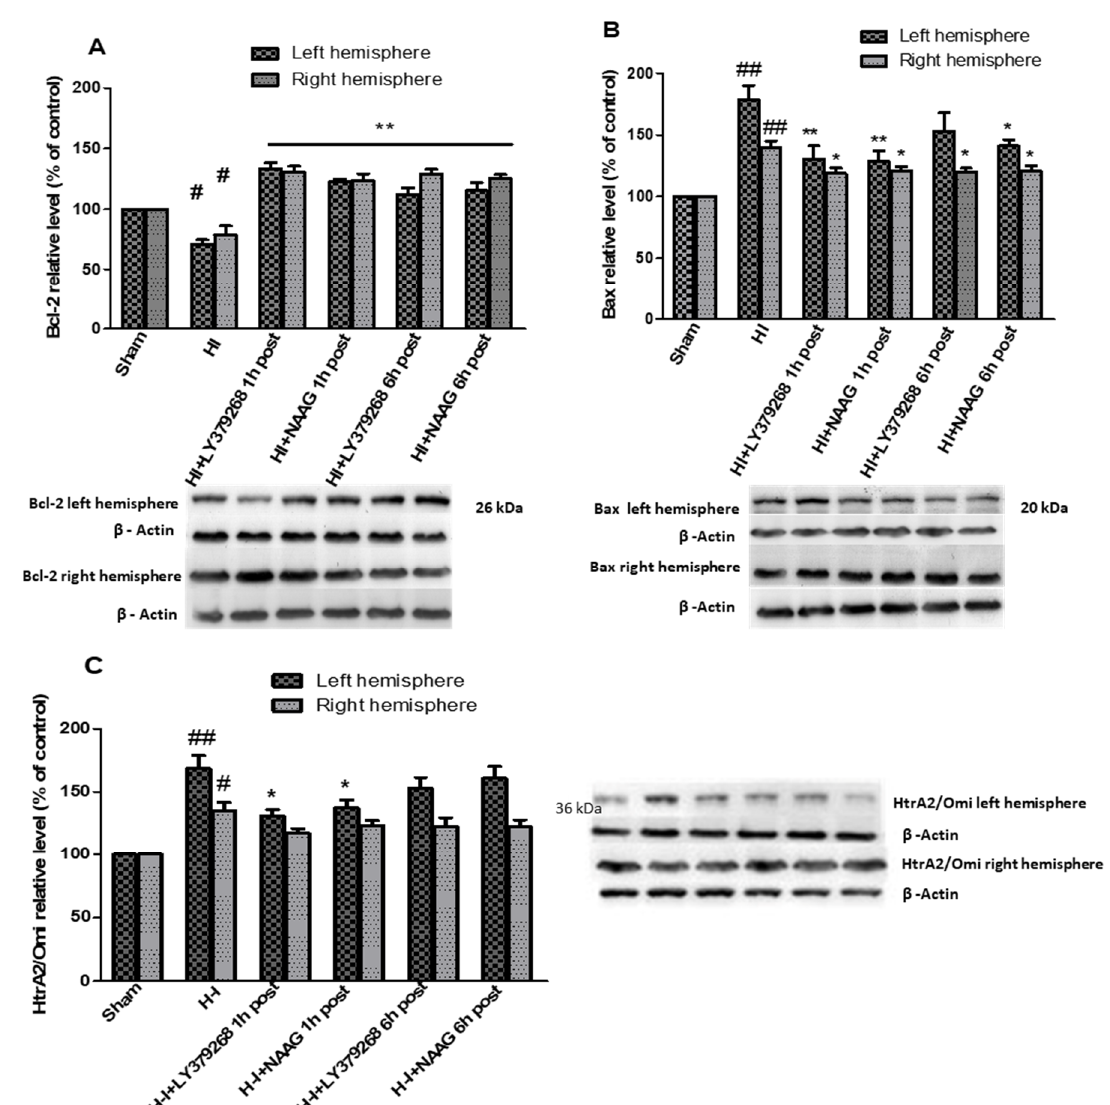
Figure 2. The effect of mGluR2 and mGluR3 agonists application on HI induced changes in Bcl-2 ( A ), Bax ( B ) and HtrA/Omi ( C ) expression in the brain. Results are presented as the mean ± SEM, n = 6–8; statistically significant differences: * p < 0.05. ** p < 0.01 compared to HI; ## p < 0.005, # p < 0.01 compared to the sham-operated